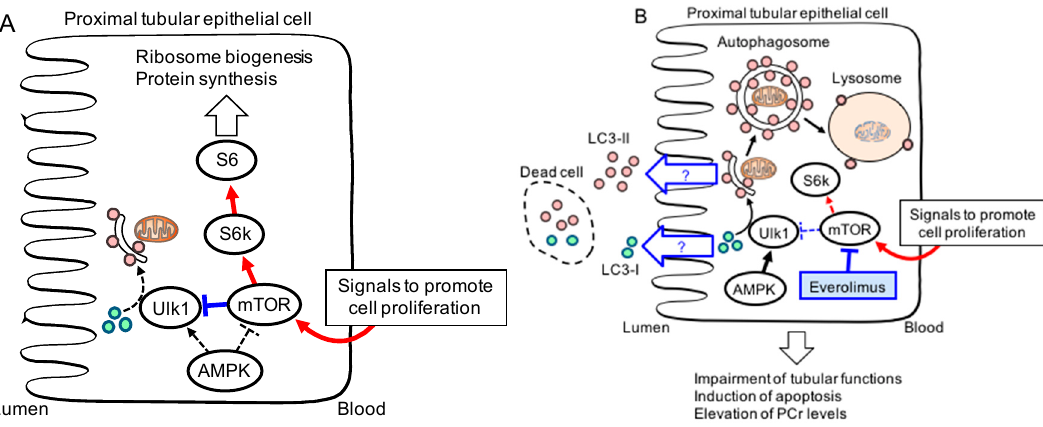
Figure 4. Hypothesized mechanisms of mammalian target of rapamycin (mTOR) inhibitor action in proximal tubular epithelial cells. Rprinted from [35]. Copyright 2012 with permission from Elsevier. ( A ) during the recovery phase of nephrotoxicant-induced tubular injury, the mTOR pathway in proximal tubular cells is activated to promote cell proliferation; ( B ) everolimus treatment exerts antiproliferative effects by blocking cell survival pathways. The quantification of urinary LC3 protein could be beneficial in predicting outcomes of treatment with mTOR inhibitors